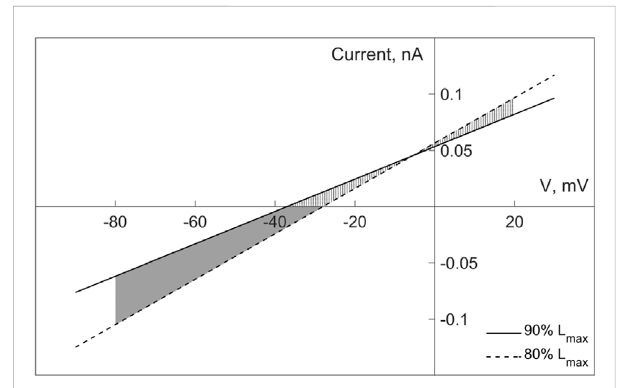
FIGURE 10 Current-voltage relationships for the non-selective mechanosensitive current in fi broblasts in model 2 , given for two lengths of 80% and 90% of L max (where L max of fi broblasts is related to L max of cardiomyocyte). The two parts of the shaded area correspond to the different polarity of the mechanosensitive current in the fi broblast, determining its depolarizing (the lower part) and repolarizing (the upper part) contribution to the fi broblast membrane potential for any instant length of the fi broblast within the range of 80% – 90% of L max